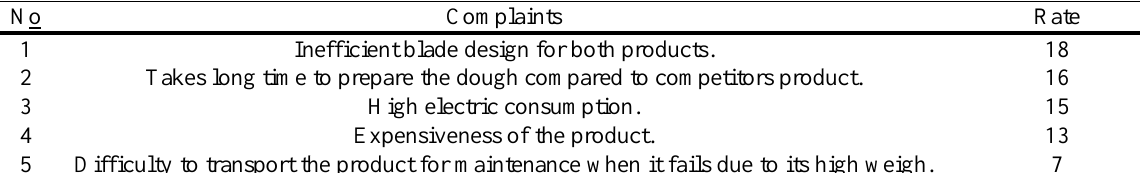
Table 2. Customer complaints on the current product.